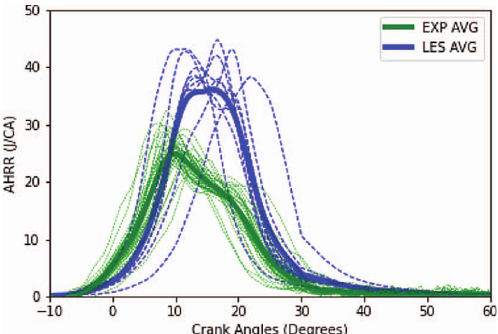
Fig. 9. WSR and LESI ignition model: in-cylinder AHRR for LES (blue) and experiments (green). Individual cycles are denoted by the dashed lines and the ensemble average is denoted by bold